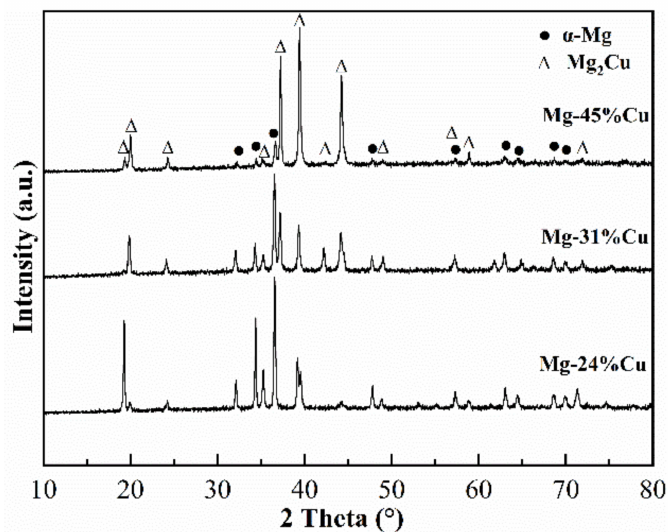
Figure 1. X-ray diffraction patterns of as-cast Mg–Cu alloys. Figure 2 reveals electron probe micro-analysis (EPMA) images of as-cast Mg–Cu alloys. Table 2 displays the composition of intermetallic phases shown in Figure 2 obtained by EDS analysis. Mg-24%Cu and Mg-31%Cu have a similar microstructure that is a typical cellular eutectic structure with dark dendrites uniformly embedded in a gray eutectic matrix. In Figure 2e,f, the light grey primary phases are embedded in the dark grey eutectic matrix.